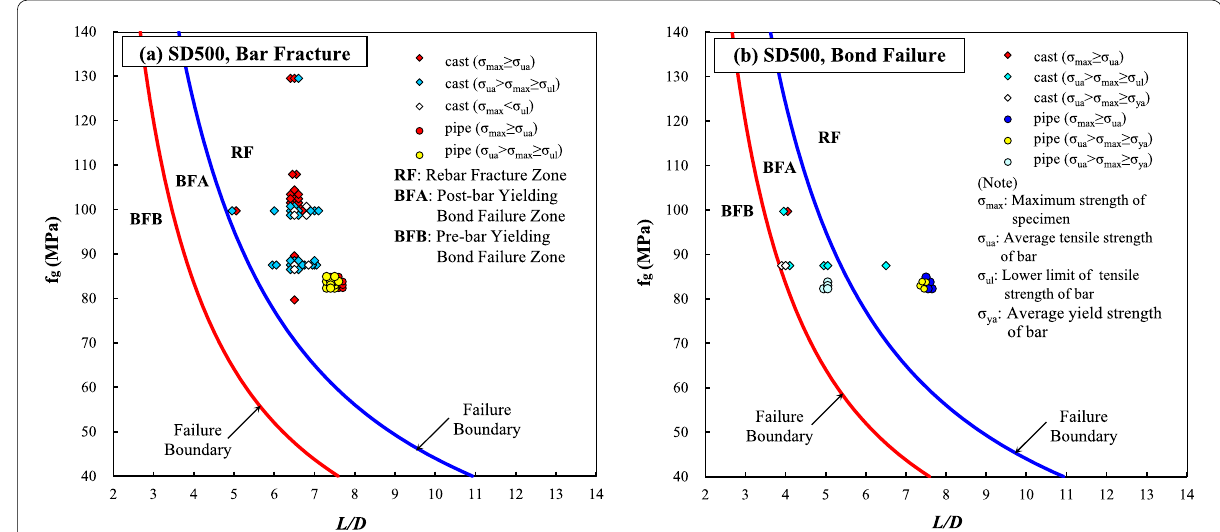
Fig. 4 Failure mode estimation based on Hayashi equation. (Test specimens with SD500)